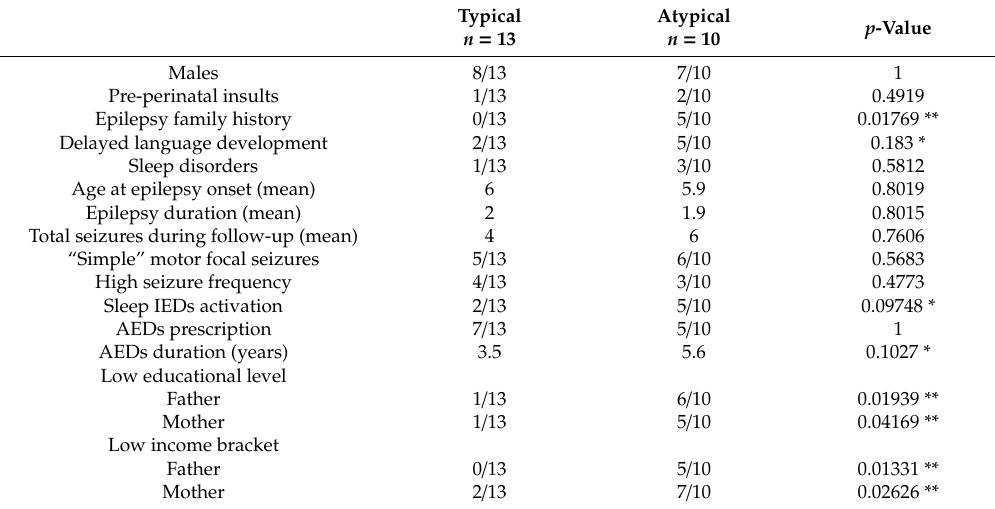
Table 3. Socio-demographical and electro-clinical di ff erences in the two groups of neuropsychological outcome. Typical patients were those who obtained fully normal scores at the neuropsychological evaluation. Atypical cases obtained diagnosis of intellectual disability, autism spectrum disorder, specific and aspecific learning disorders. The socio-demographic and clinical variables were considered statistically significant predictors of outcome if p -value ≤ 0.05 **, a trend toward significance was still considered ( p -value ≤ 0.2 *). Typical n = 13